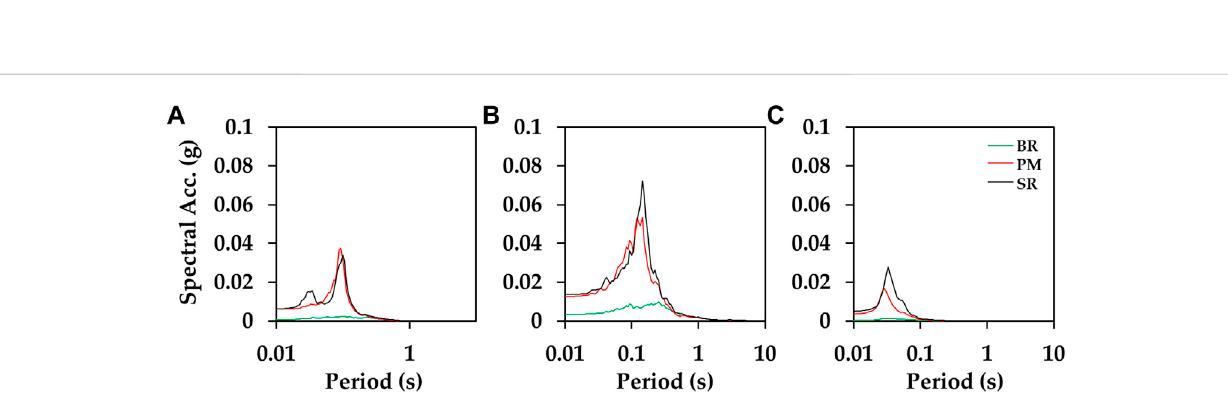
FIGURE 11 Comparison of response spectra: stations (A) HAMB, (B) IMWB, and (C) YOCB. (BR: borehole record; PM: proposed model; SR: surface